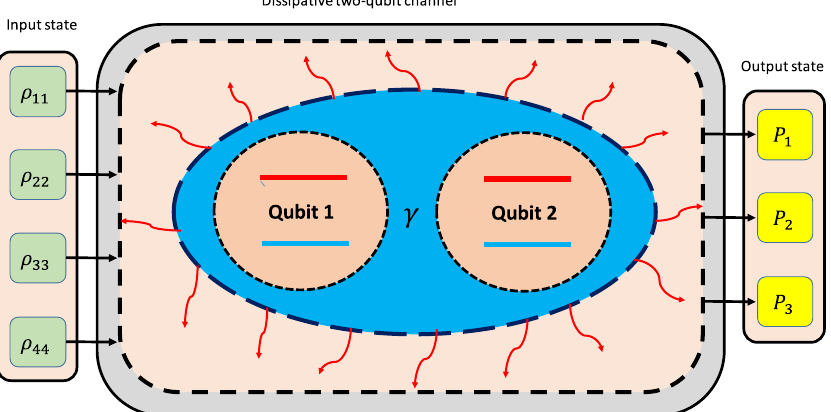
Figure 2. Schematic of the DQC. The channel constitutes a two-qubit system plunged into a global thermal reservoir. Since the steady state of the DQC depends on its initial state, hence it can be used for quantum machine learning. Note that, the input data are encoded into the initial density matrix of the two-qubit system. The channel maps the input data onto the steady state of the two-qubit system via the transformation, ρ( 0 ) −→ ρ( ∞ )